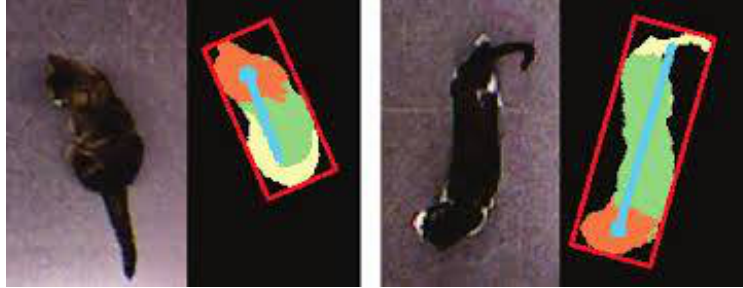
Figure 11. Tracking cats using depth measurement via an Xbox Kinect to detect posture [51].